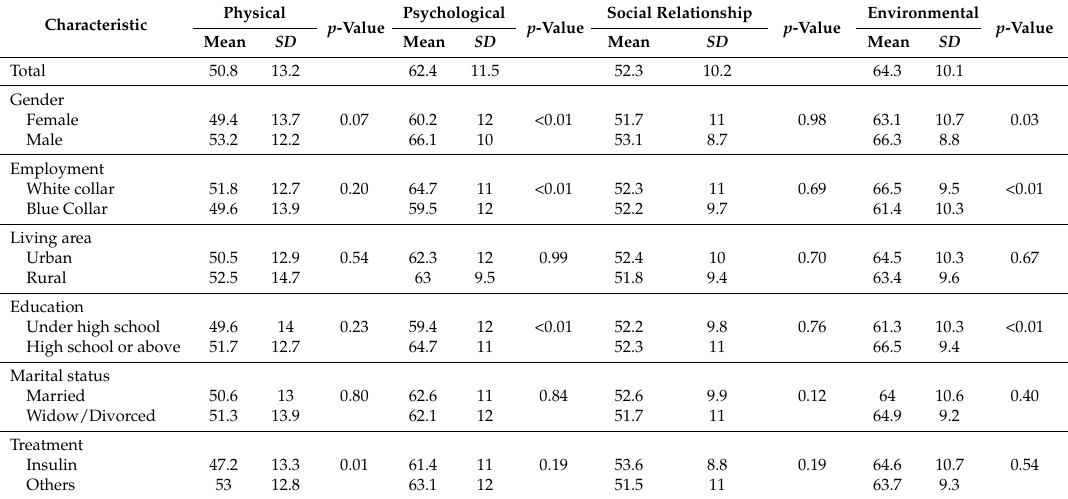
Table 3. Differences in the World Health Organization Quality of Life-Brief scale (WHOQOL-BREF) domain scores between demographics